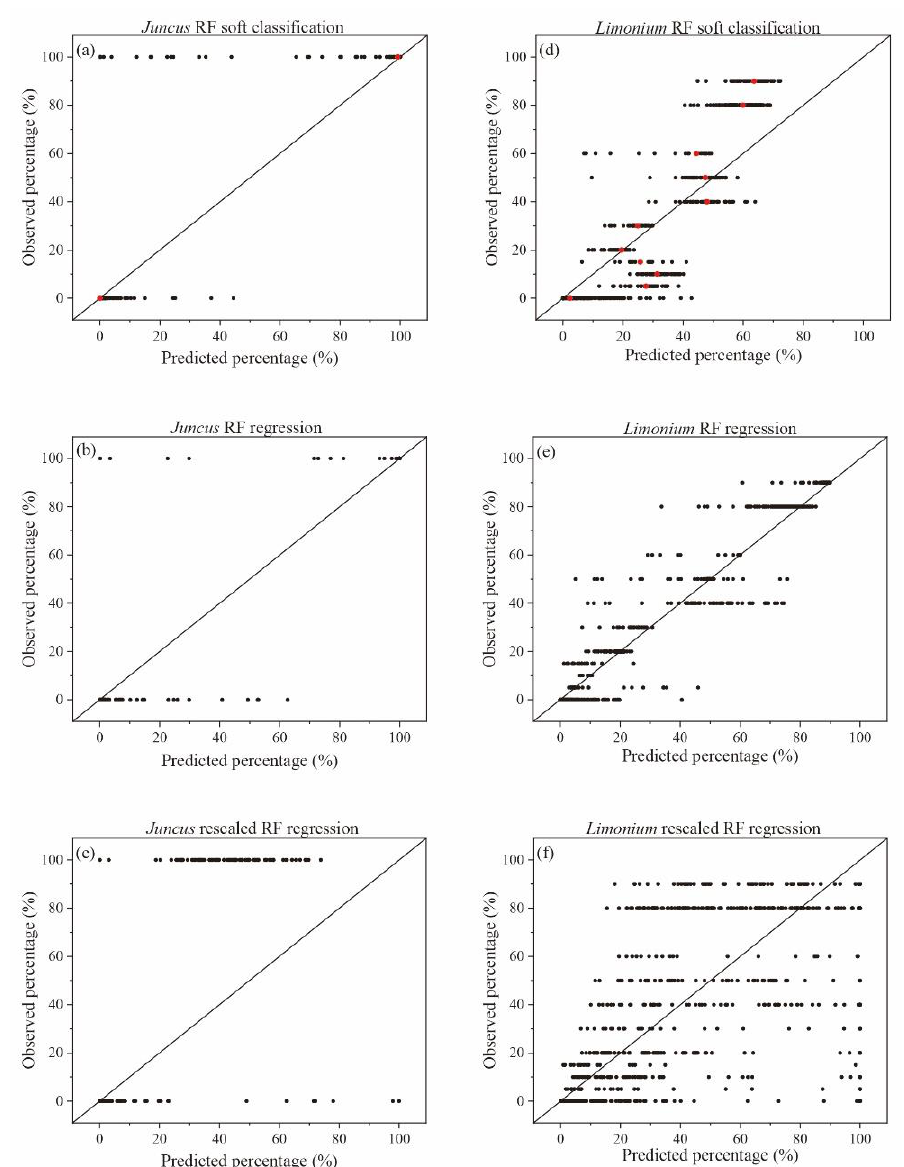
Figure 7. Validation results for Juncus and Limonium : ( a , d ) are predicted probabilities (x-axis) plotted against the validation data; ( b , e ) are regression results (x-axis) plotted against the validation data; ( c , f ) are rescaled regression results (x-axis) plotted against the validation data. Red dots represent the mean of the predicted percentage using the RF soft classification.